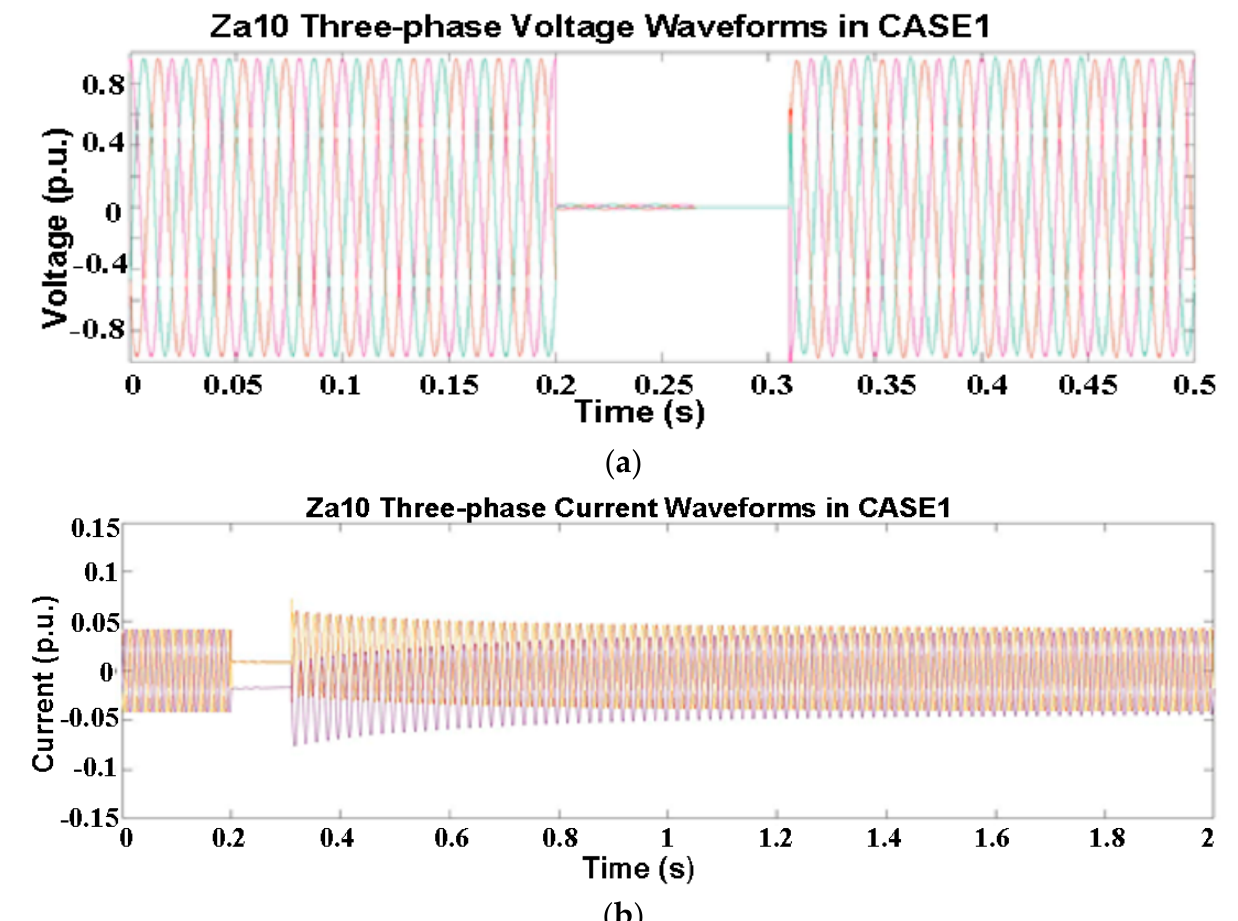
Figure 5. CASE 1 waveforms at Za7 after fault isolation; ( a ) voltage, ( b ) current.